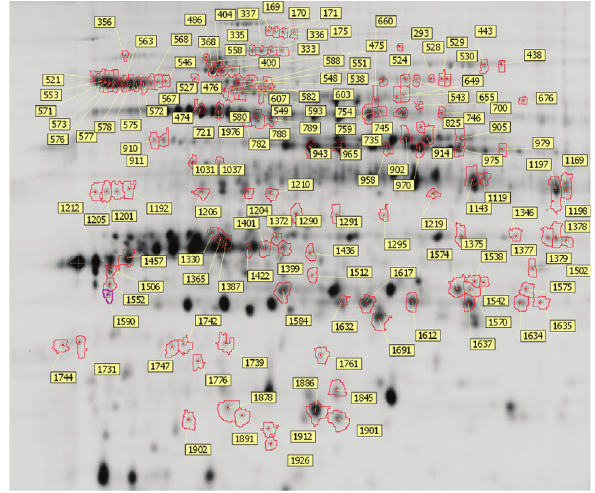
Figure 3 - Differentially expressed D. salina protein spots identified by DIGE analysis between high and low salinity (3 M/0.75 M NaCl). Based on detailed image analysis, spot numbers with differences in standardized average spot volume ratios > 1.5 and a t-test < 0.05 are shown.